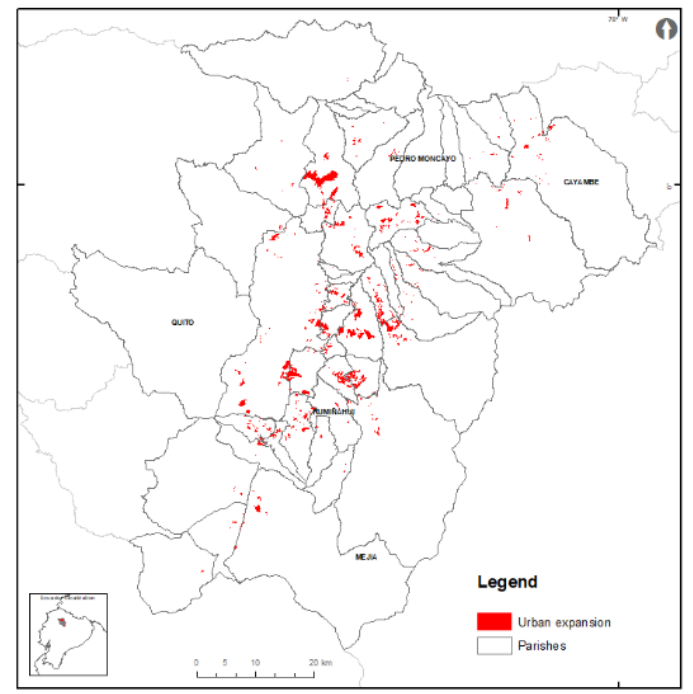
Figure 7. Urban expansion areas established by the Ecuadorian Space Institute (IEE), 2013.